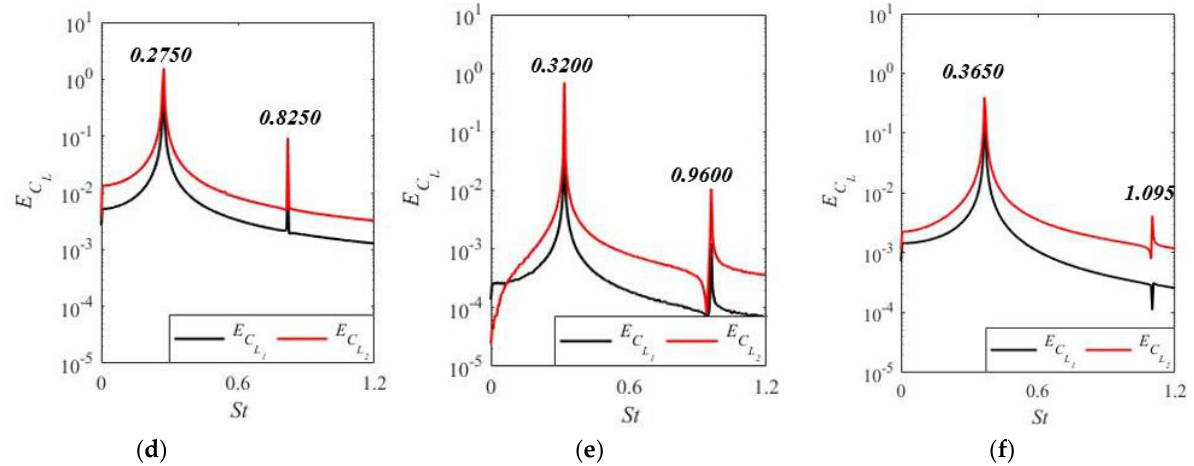
Figure 6. The PSD 𝐸 𝐶 and 𝐸 𝐶 : ( a ) 𝐿/𝐷 = 1.56 , ( b ) 𝐿/𝐷 = 1.8 , ( c ) 𝐿/𝐷 = 2.5 , ( d ) 𝐿/𝐷 = 3, ( e ) 𝐿/𝐷 = Figure 6. The PSD E C and E C : ( a ) L / D = 1.56, ( b ) L / D = 1.8, ( c ) L / D = 2.5, ( d ) L / D = 3, 𝐿1 𝐿2 L 1 L 2 3.7 , ( f ) 𝐿/𝐷 = 4 . ( e ) L / D = 3.7, ( f ) L / D = 4.